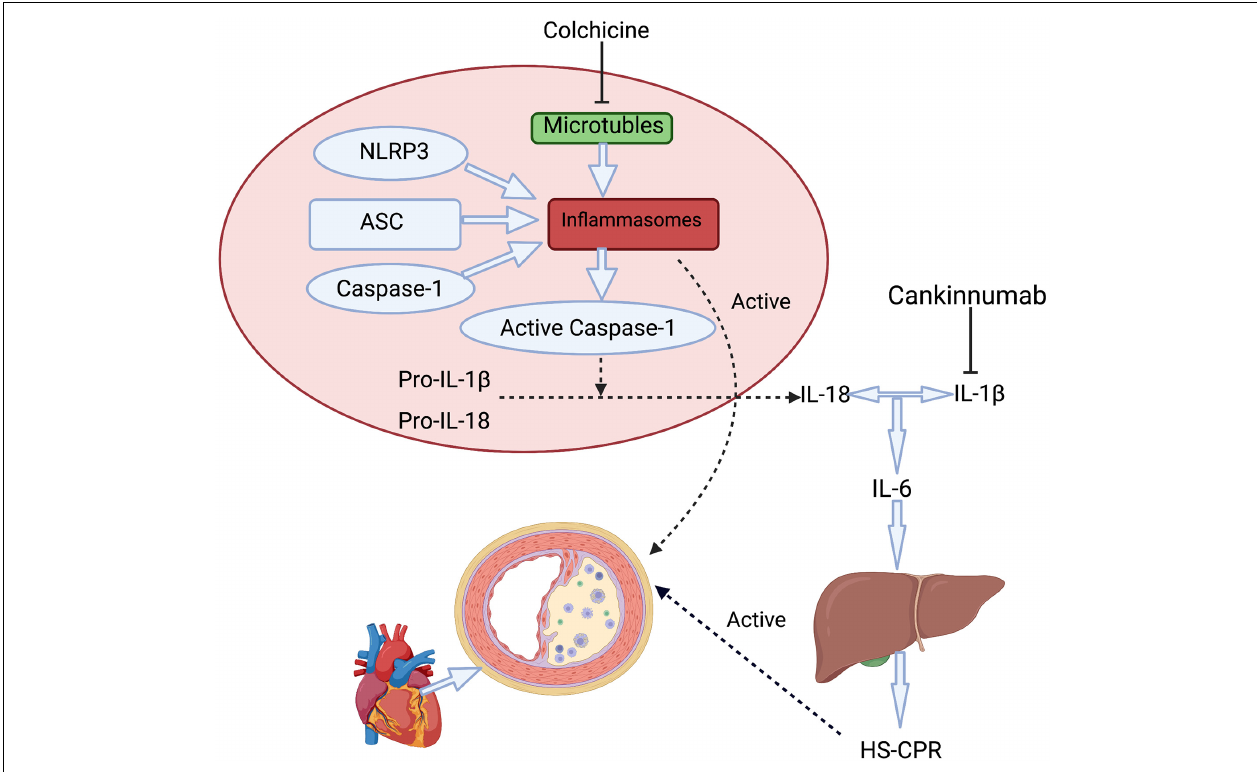
FIGURE 2 | A simplified approach to inflammasome activation pathways includes therapy mechanisms of colchicine and canakinumab. Colchicine affects the NLRP3 inflammasome by inhibiting the function of microtubules, further resulting decrease in the downstream inflammatory factors include IL-1 β , IL-6, and HS-CRP. Canakinumab prevents IL-1 β and further reduces the release of IL-6 from various types of cells. hs- CRP is produced in hepatic through regulation by IL-6. ASC, apoptosis-associated speck-like protein containing a CARD; NLRP3, NLR family pyrin domain containing 3; IL, interleukin; hs- CRP, High-sensitivity C-reactive